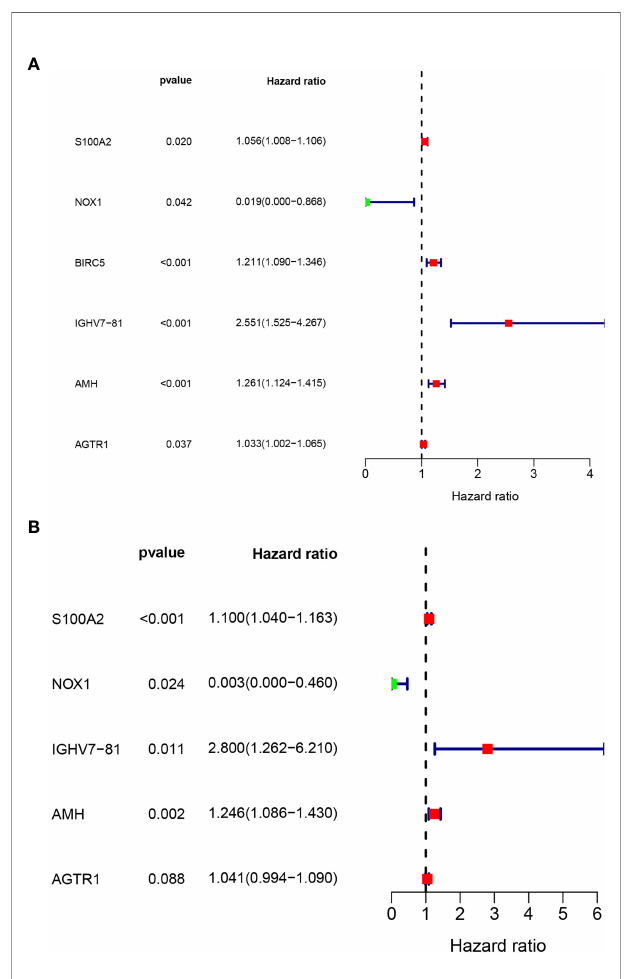
FIGURE 5 | Prognostic IRGs identi fi cation: (A) Univariate and (B) Multivariate Cox regression analyses.